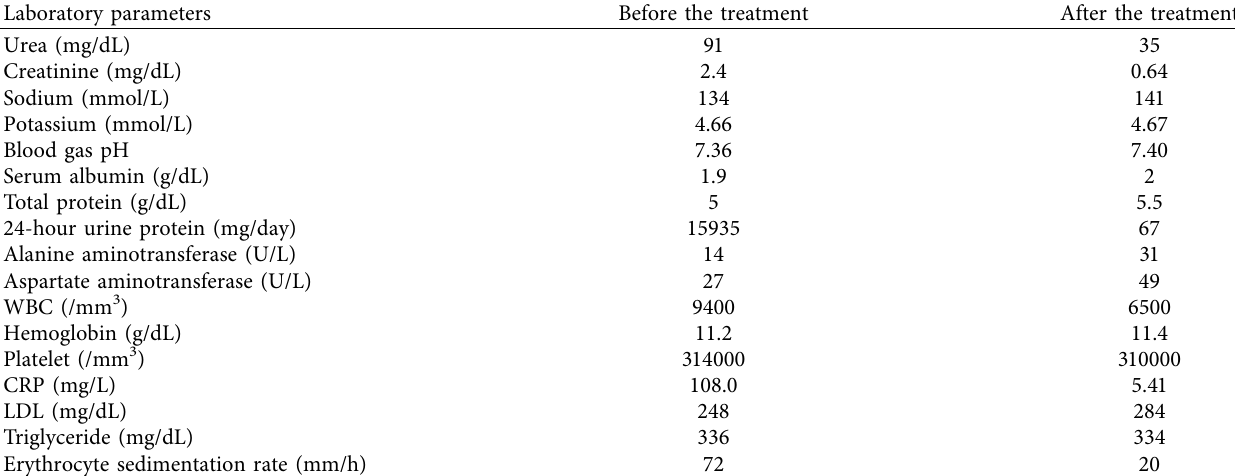
Table 1: Laboratory parameters of the patient before the treatment (admission to the hospital and 1 week after the 2nd vaccination) and after the